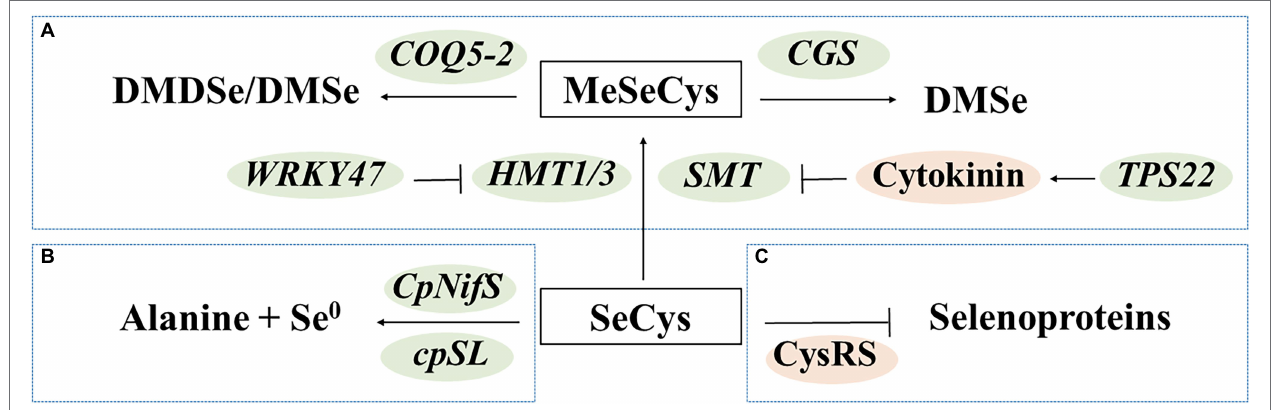
FIGURE 3 | Transgenic approaches to regulate seleno-amino acids in plants. (A) Production of methylated and/or volatile forms; (B) Decomposition of SeCys; and (C) Reduction of misincorporation. DMDSe, dimethyl diselenide; DMSe, dimethyl selenide; MeSeCys, Se-methylselenocysteine; and SeCys,